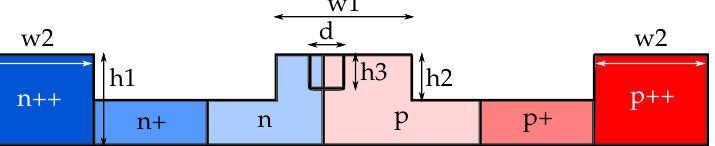
Figure 2. Cross-section of the doped part of the ring. N and P are for the electrons and holes concentrations, respectively: ++ is 10 20 cm − 3 , + is 10 19 cm − 3 , and without sign is 5 × 10 18 cm − 3 . d and h3 denote the hole diameter and height,